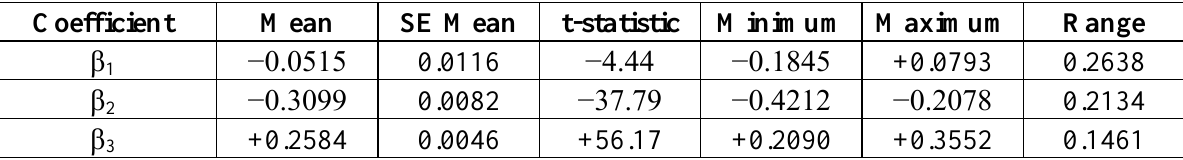
Table 5. Descriptive Statistics Using Monthly Observations from Equation (5), 1/2006 to